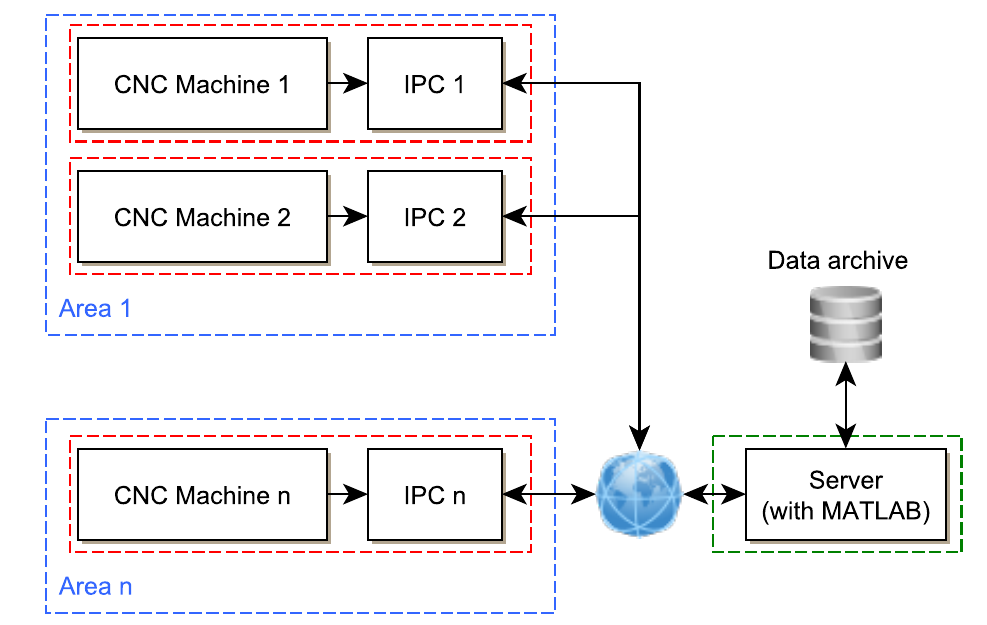
Figure 12. IPC and server location